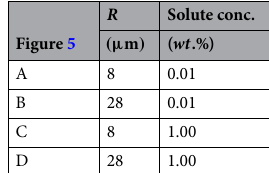
R Solute conc. Figure 5